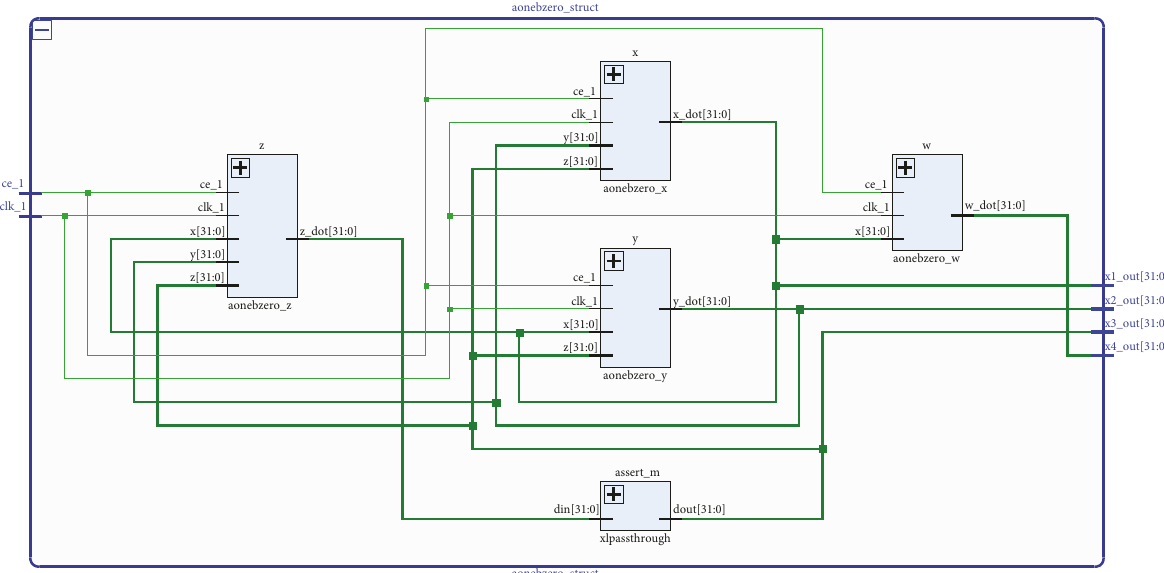
Figure 26: RTL schematics of FONCS-4 system.